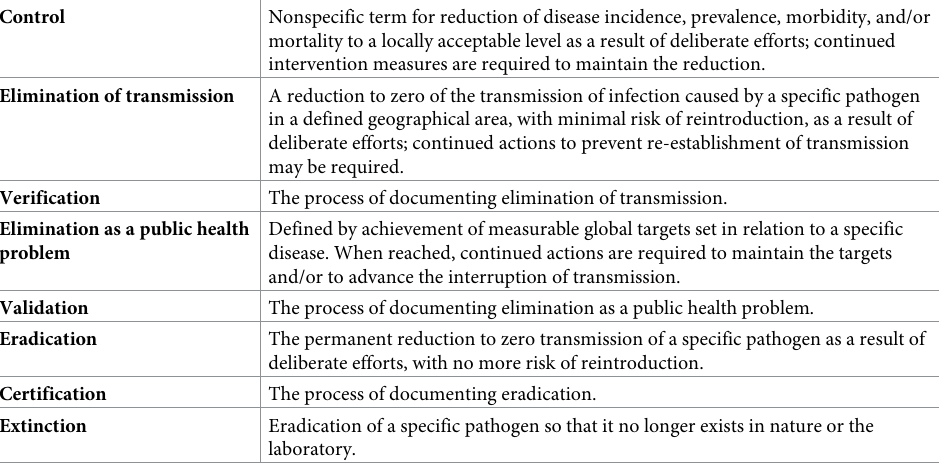
Table 1. Essential terms and concepts for defining goals and targets to limit infectious disease epidemics